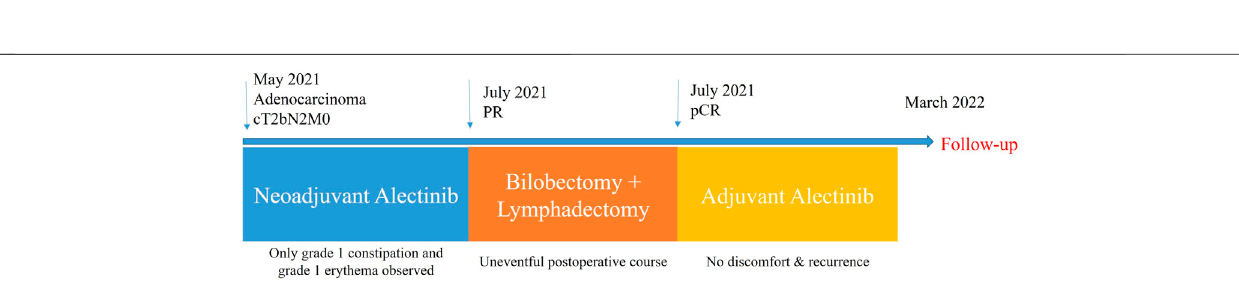
Frontiers in Pharmacology |